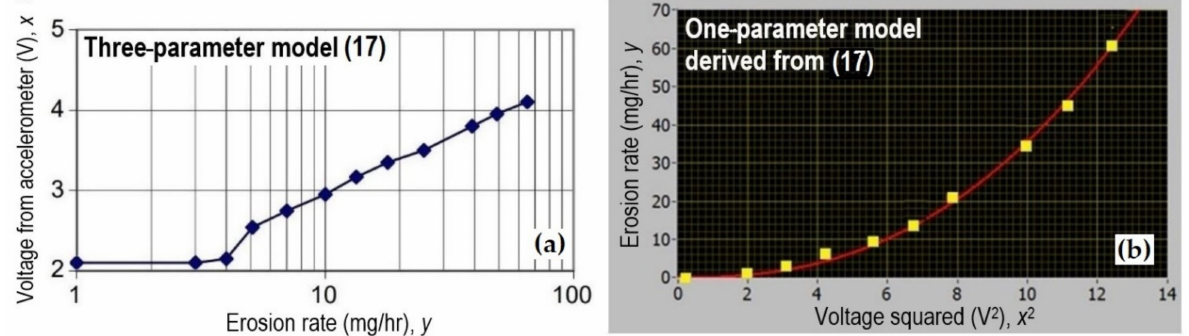
Figure 3. Front panel of the multidimensional data acquisition processor. The simplest description of cavitation comes out online after half an hour of measurement on the prototype. More compli- cated descriptions require days or weeks of recorded data analysis by a trained user.